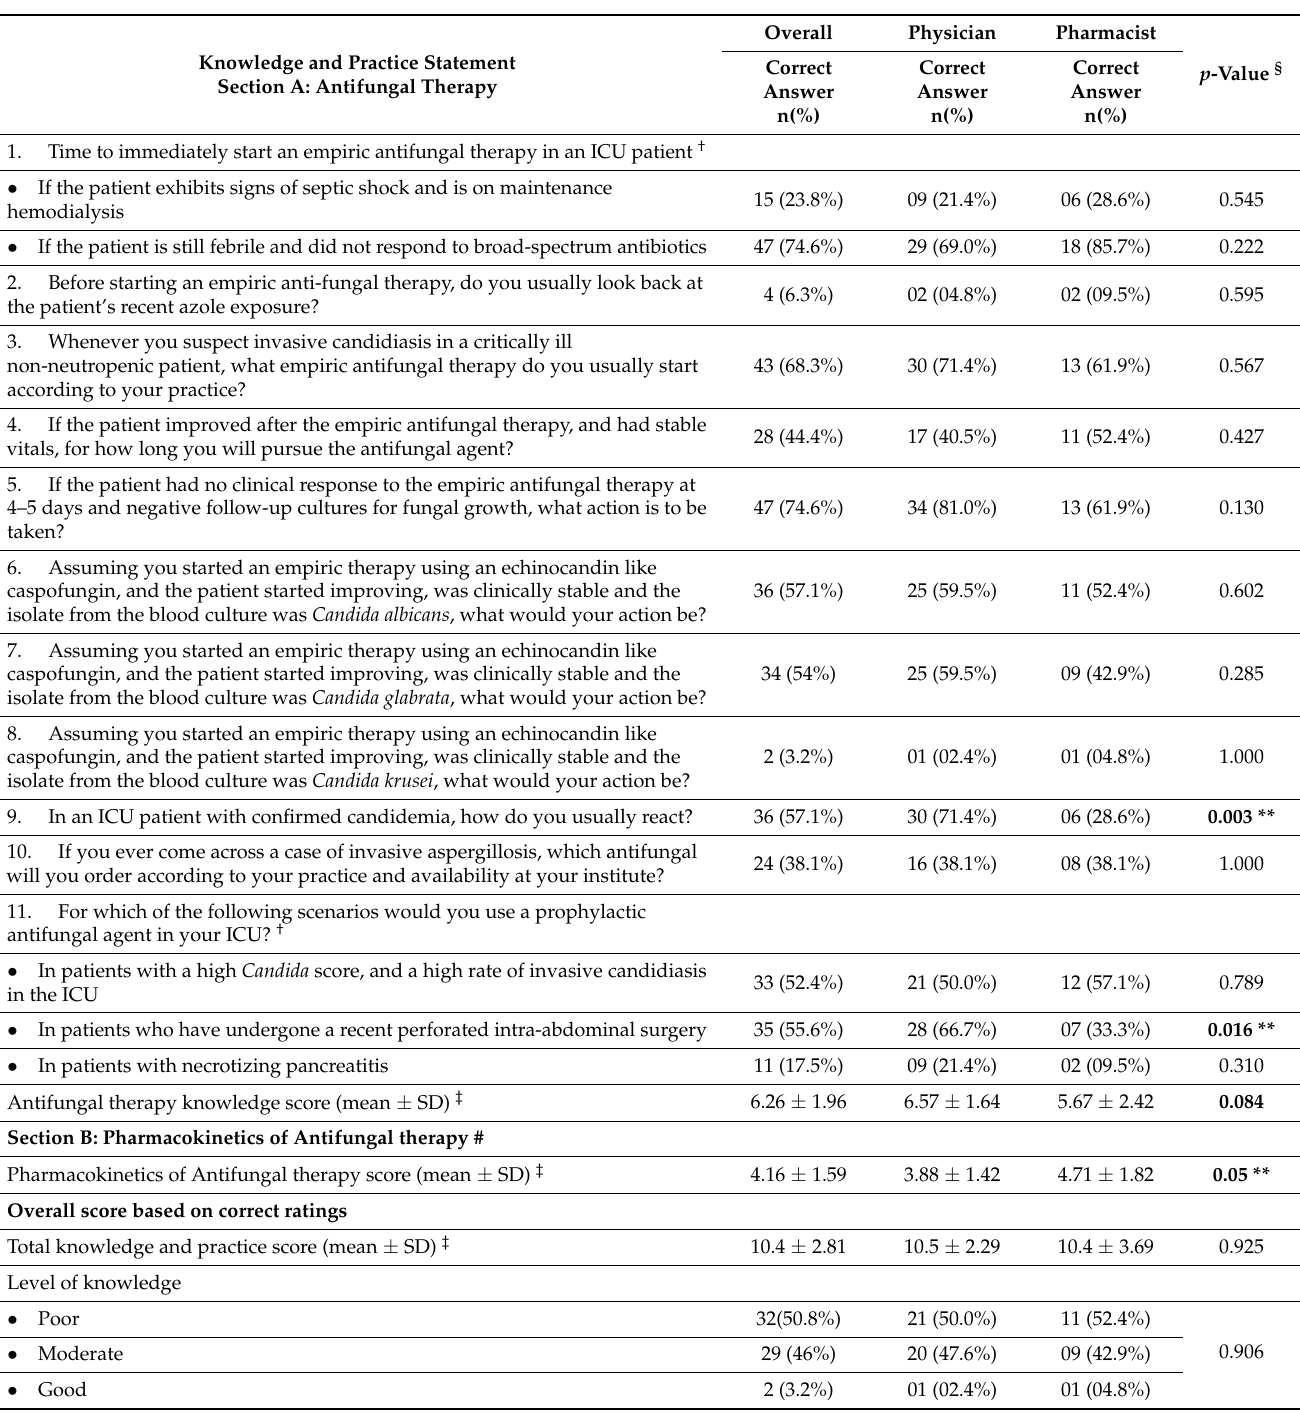
Table 2. Assessment of systemic antifungal prescribing knowledge and practice among physicians and pharmacists (n = 63)